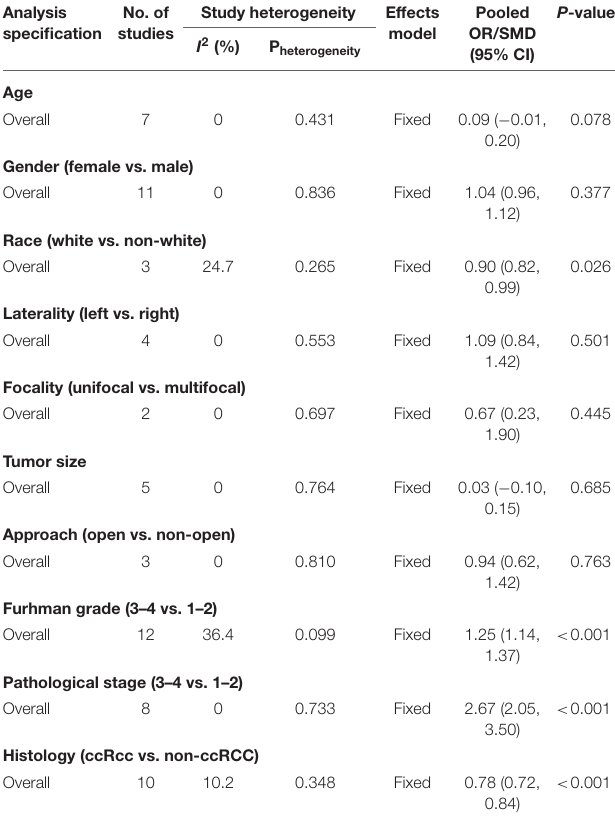
TABLE 3 | Summary of the meta-analysis for the associations between PSMs and clinicopathological features in RCC patients. Analysis No. of specification